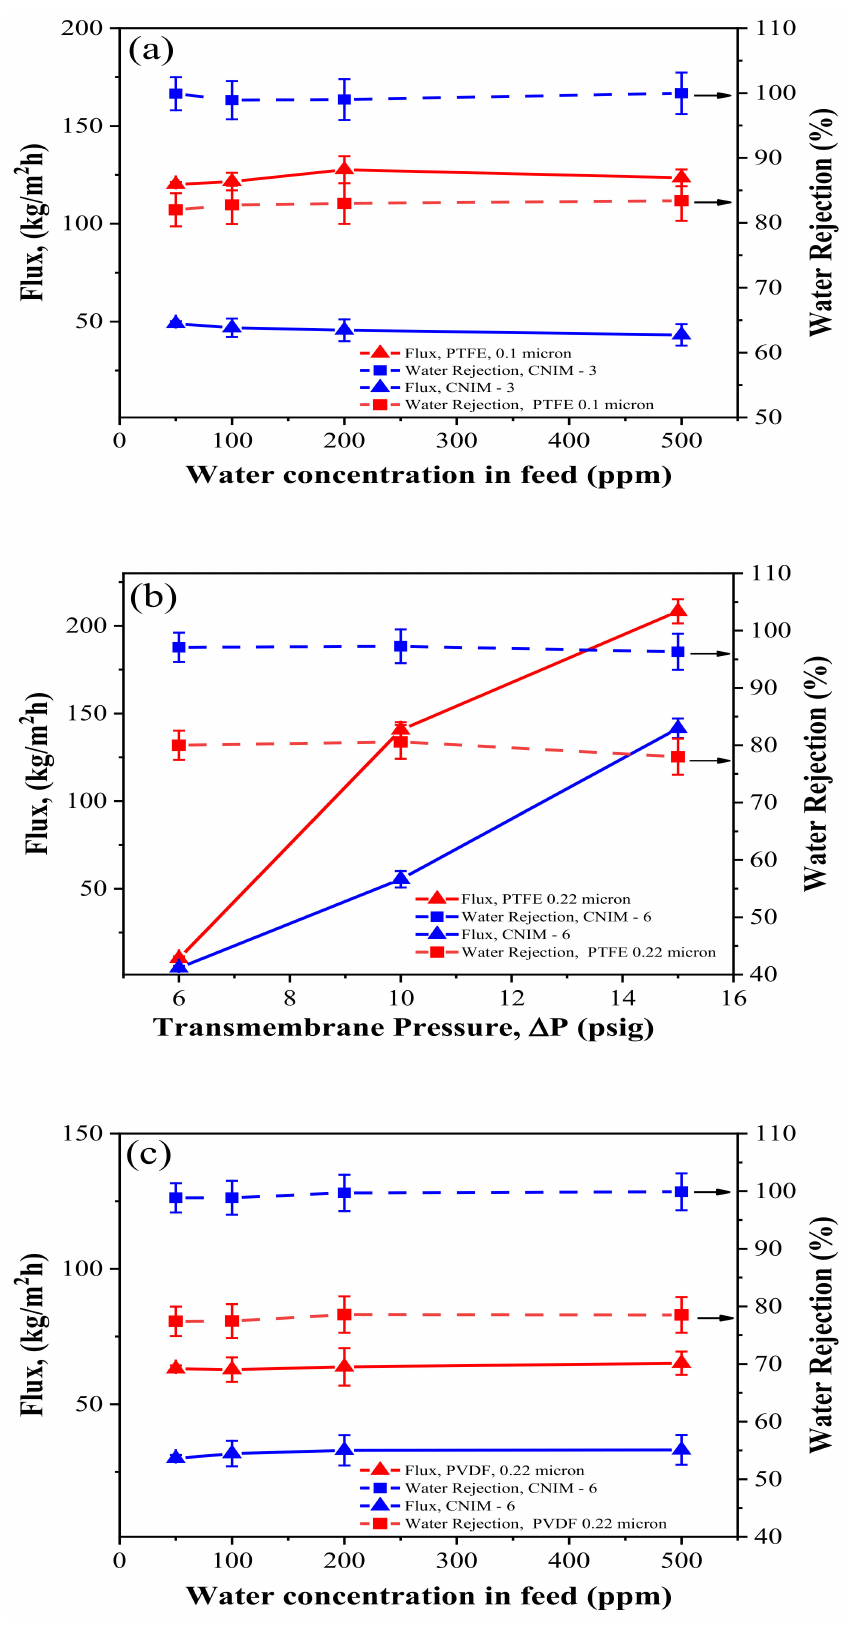
Figure 5. Effect of water concentration on kerosene flux and water rejection at a transmembrane pressure of 10 psig and feed flowrate of 40 mL/min for ( a ) PTFE (0.1 µ m) and CNIM-3, ( b ) PTFE (0.22 µ m) and CNIM-6 and ( c ) PVDF (0.22 µ m) and